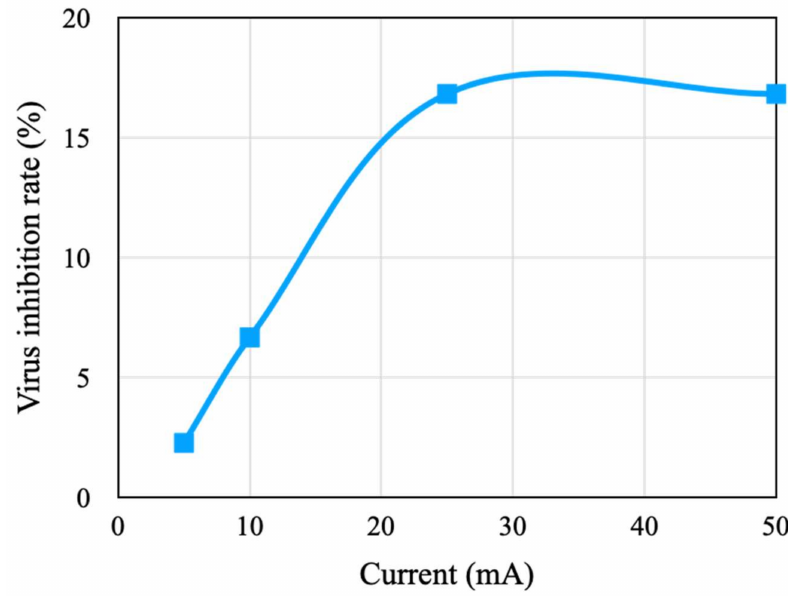
Figure 7. Viral activity-inhibition rates under different stimulation currents.